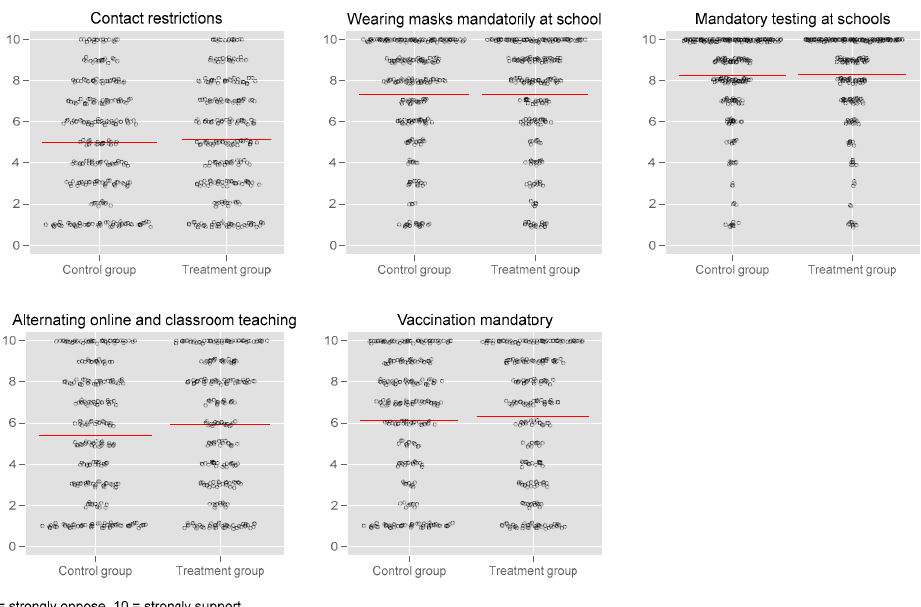
Figure 3. Approval ratings of general anti-COVID-19 measures in treatment and control groups (+group means).